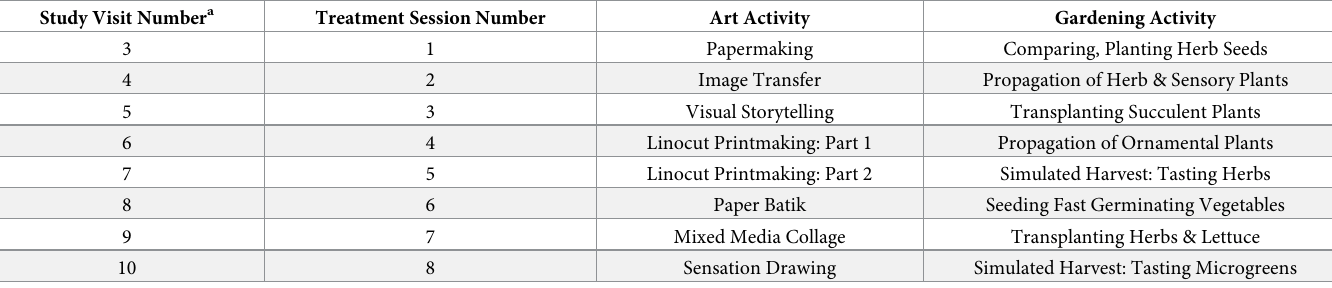
Table 1. List of art and gardening intervention sessions and participant visitation